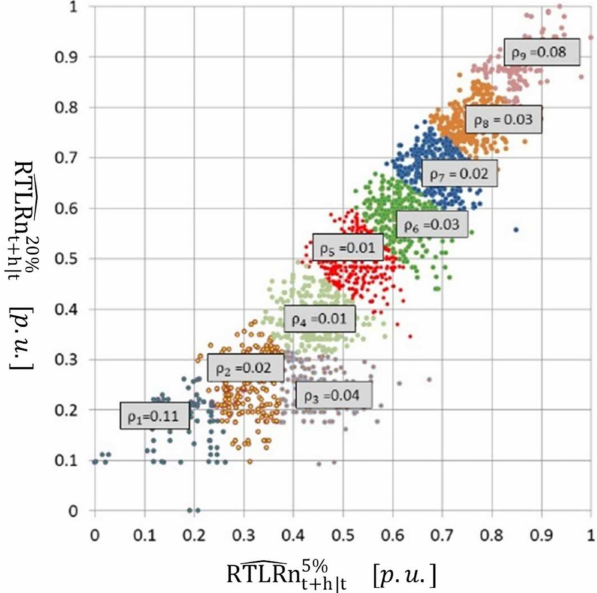
Figure 4. Example of nine clusters generated for RTLR forecasts, with the associated values of ρ